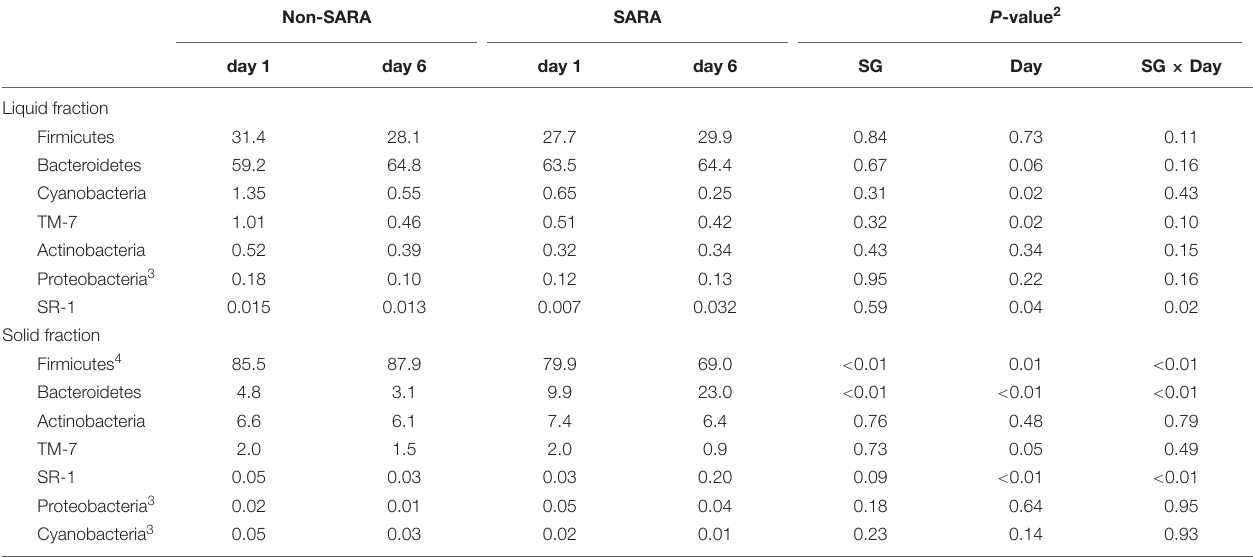
TABLE 3 | Effect of SARA induction on relative abundances of bacterial phyla in the solid fraction using 16S rRNA sequencing. 1